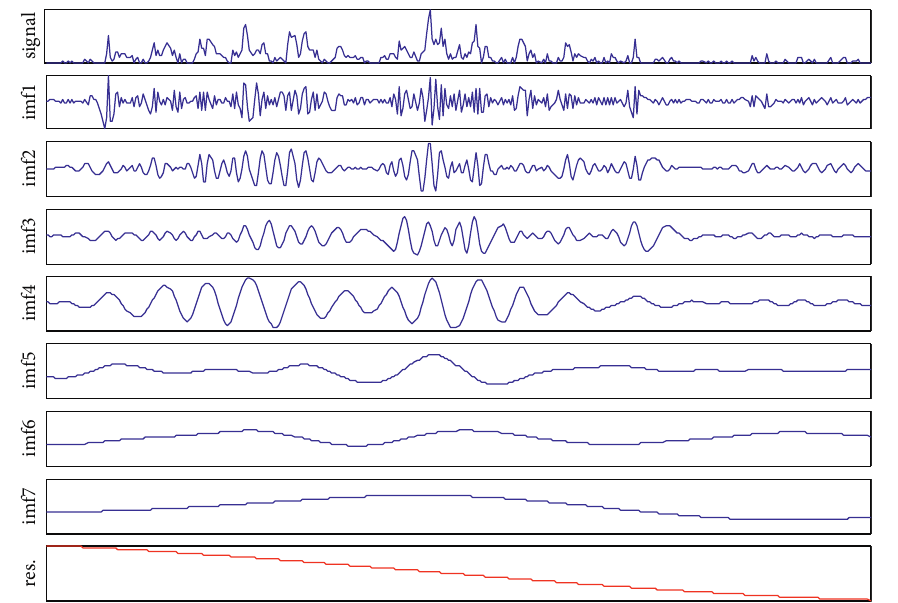
Figure 4: Empirical mode decomposition (EMD) exploded view of “plastic laver” network rumor.